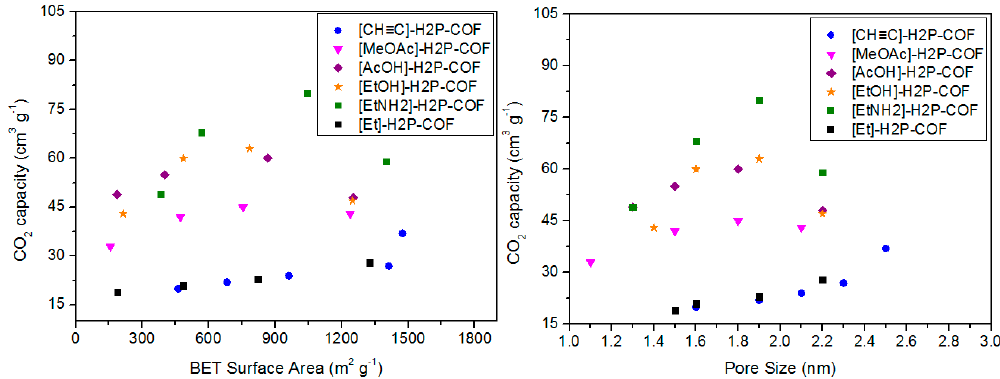
Figure 28 . Plot of low-pressure CO 2 uptake against BET surface area ( left ) and pore size ( right ) for the selected COFs at 273 K and 1 bar.